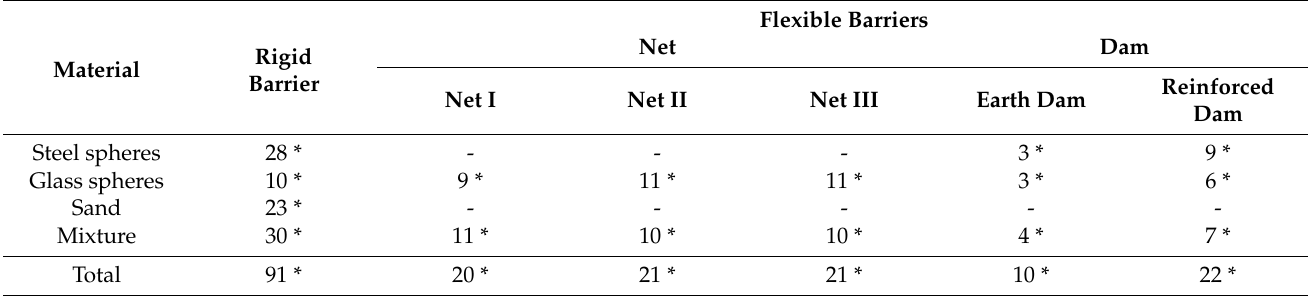
Table 4. Number of laboratory experiments at the University of Innsbruck.